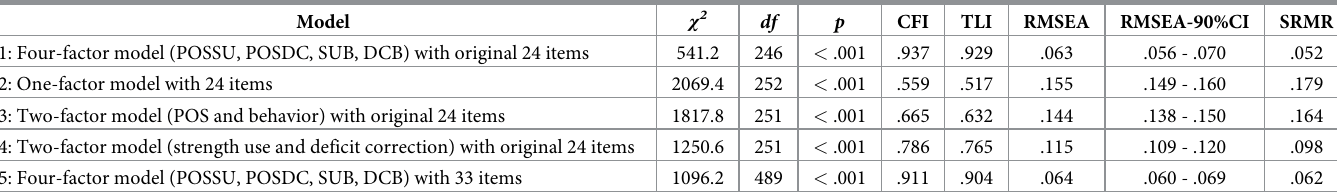
Table 1. Measurement models for Study 1 using MLM